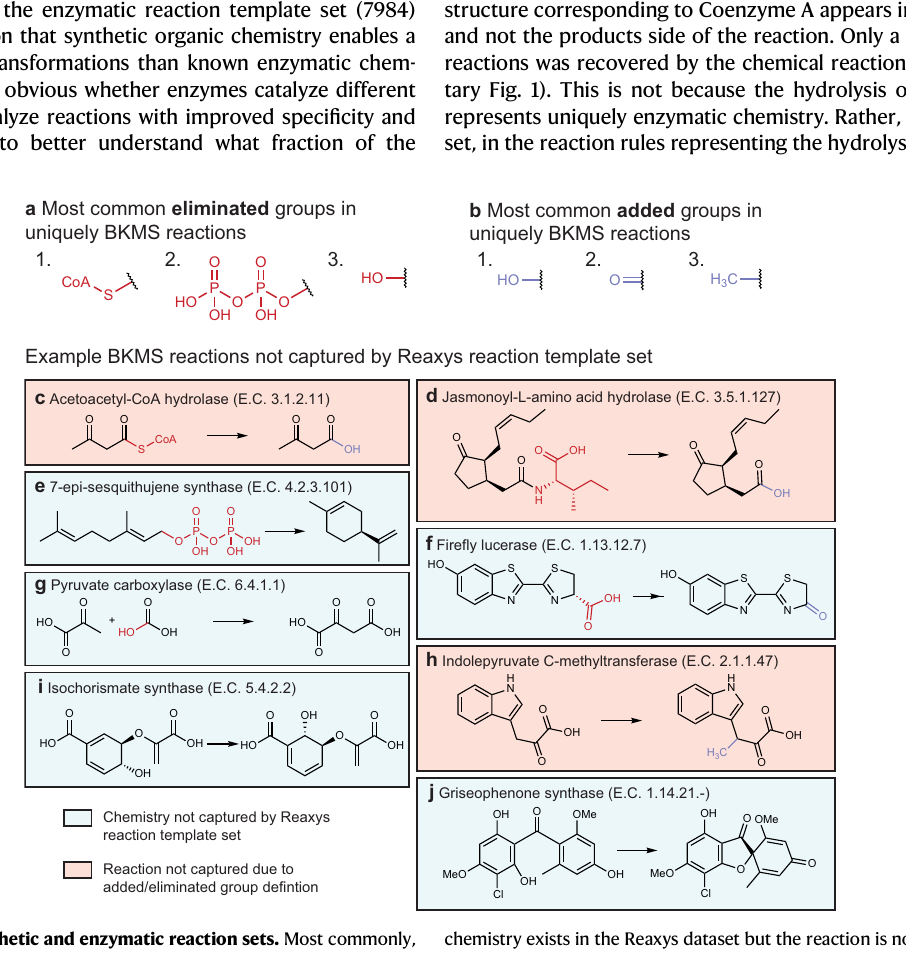
chemistry exists in the Reaxys dataset but the reaction is not captured because of how eliminated/added groupsare handledare highlighted inorange and reactions whicharetrulynotcapturedbythechemistryintheReaxysdatasetarehighlighted in